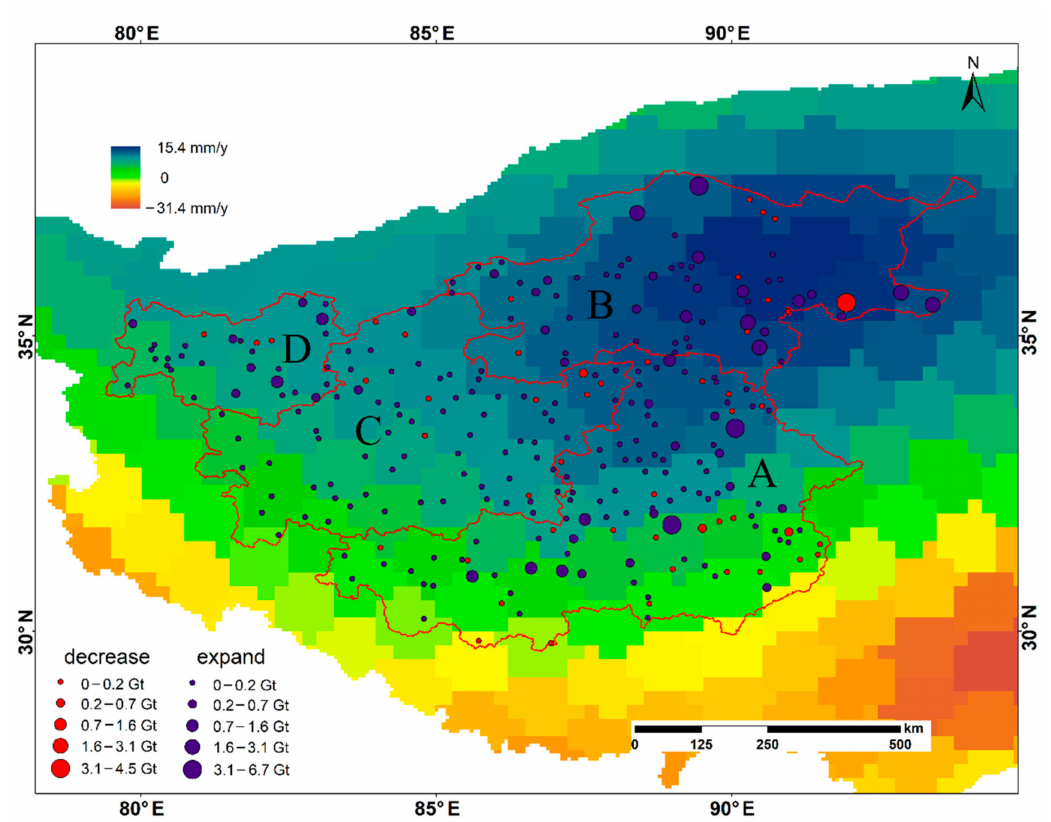
Figure 3. The spatial distribution of LWSC from SRTM and Landsat image, and TWSC from GRACE data during 2005–2013. The red line represents the boundary of four subregions, and the background represents the changing rate of TWS during